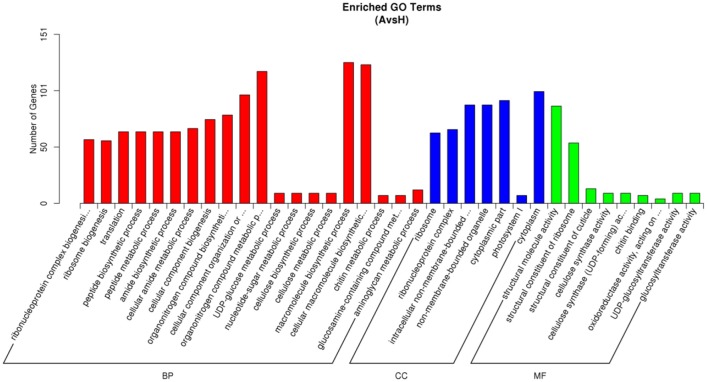
GO classifications of DEGs between transgenic AANAT and HIOMT lines in three main categories: biological process (BP), cellular component (CC), and molecular function (MF).